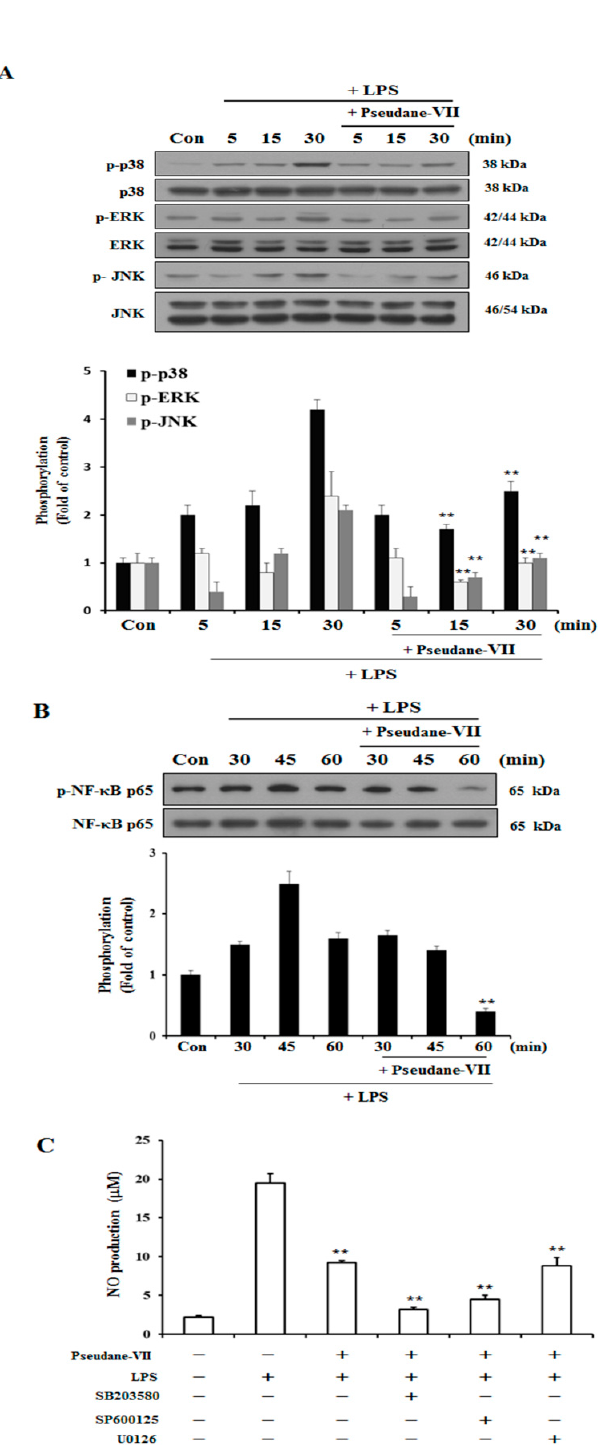
Figure 5. Pseudane-VII regulates LPS-induced phosphorylation of p38, ERK, JNK and NF- κ B. ( A , B ) Cells were starved by using serum-free DMEM for 4 h. Next, cells were pretreated with 5 µ M pseudane-VII for 2 h and stimulated with LPS (200 ng/mL) for 5, 15 and 30 min. Cells were lysed using RIPA buffer. Whole cell lysates was separated by SDS-PAGE and transferred to PVDF membranes. These membranes were attached to several antibodies (anti-p-p38, p38, p-ERK, ERK, p-JNK, and JNK antibodies). ( C ) The cells were pretreated with 10 µ M of SB203580, SP600125, U0126 for 1 h and then added with 5 µ M pseudane-VII for 2 h. After 2 h, the cells were stimulated with LPS (200 ng/mL) for 21 h. NO production was measured. Result was from representative experiments that confirmed identical patterns. (** p < 0.001 vs. LPS-stimulated group).